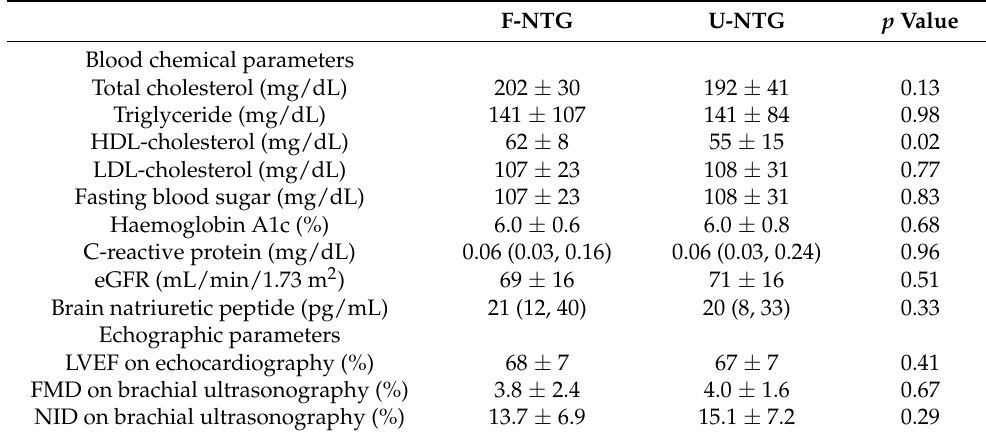
Table 2. Blood chemical and echographic parameters.